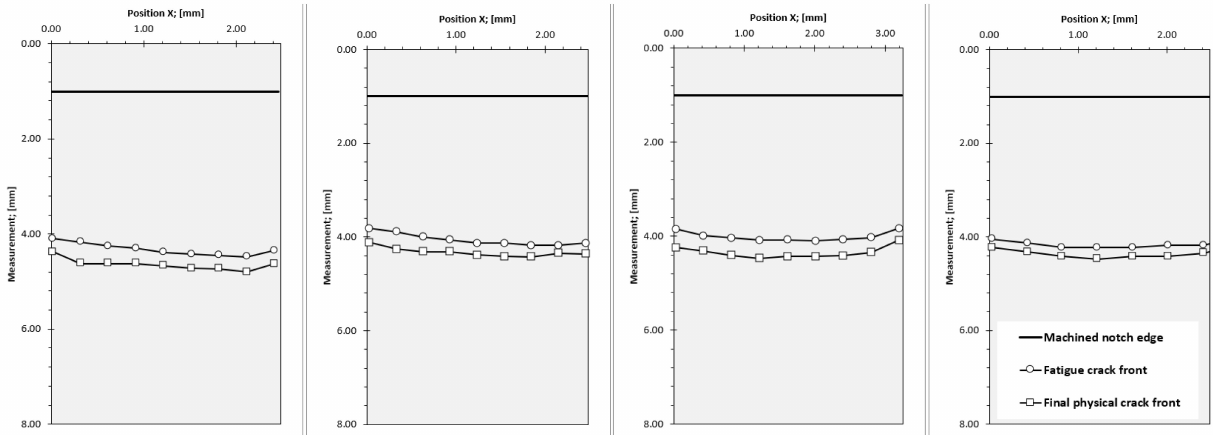
Figure 8. Fracture surface measurements of samples.